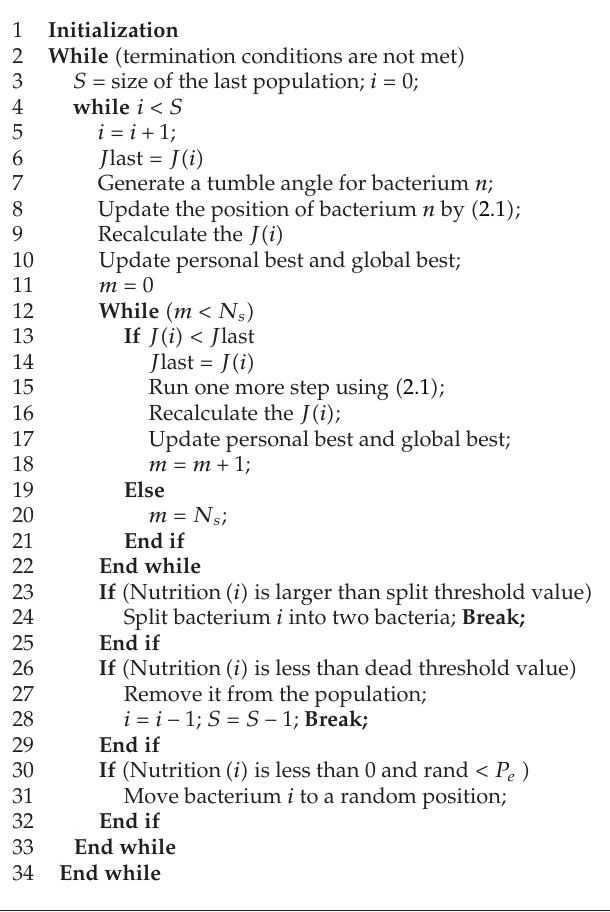
P SEUDOCODE 2: Pseudocode of BFOLS